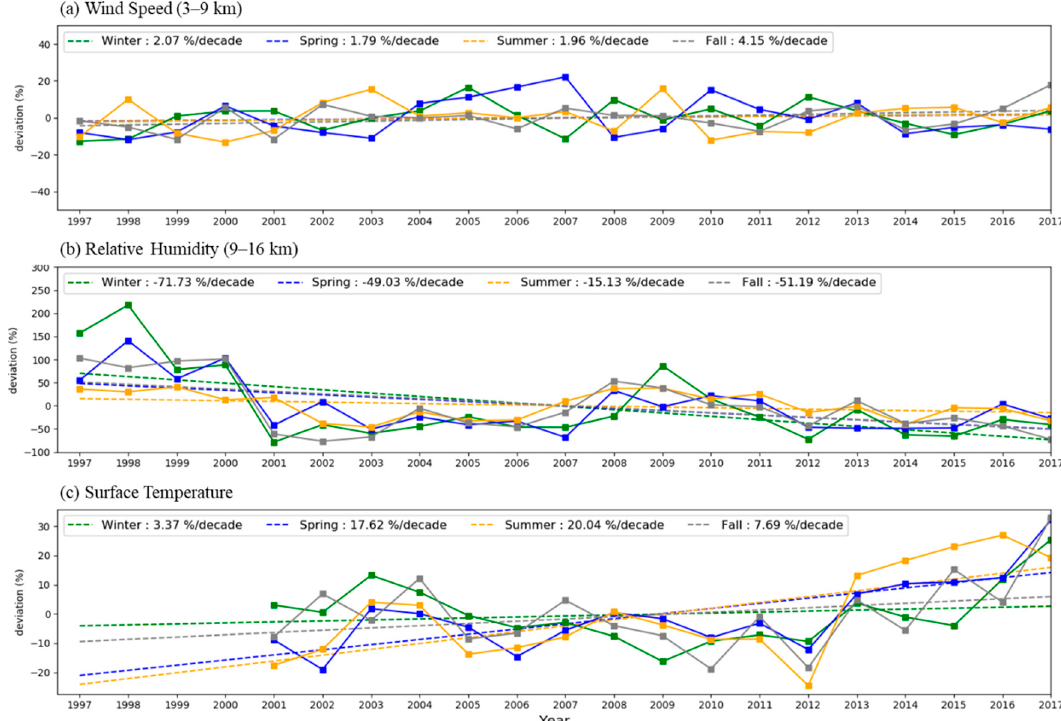
Figure 5. Time series of percent deviations in the de-seasonalized average ozone (DU) of ( a ) wind speed of the upper troposphere (3–9 km), ( b ) humidity of the SOPL, and ( c ) surface ozone for each season. The solid and dashed lines indicate the annual mean and trend, respectively (green: winter, blue: spring, yellow: summer, gray: fall).